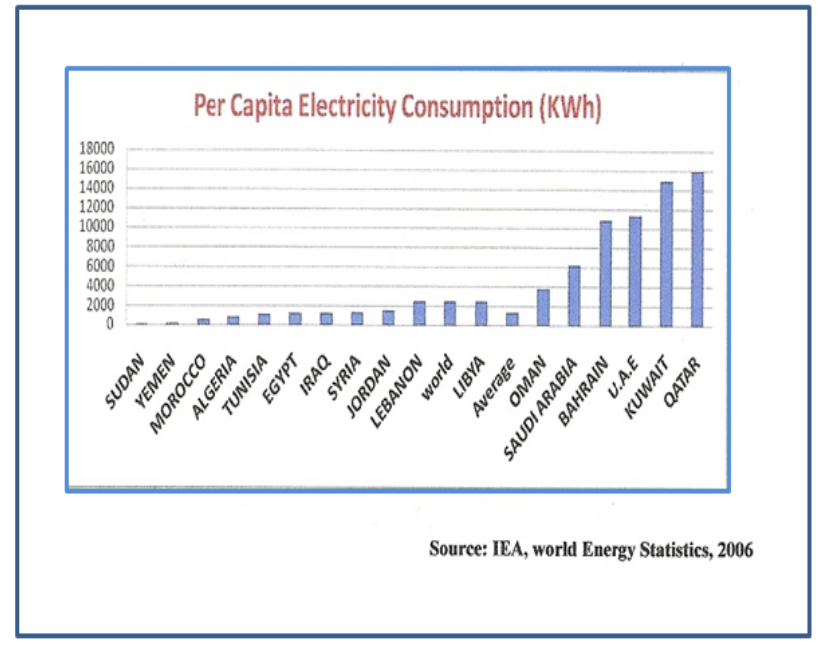
Figure 8. Pro-capite consumption of electricity for Arab countries [9].